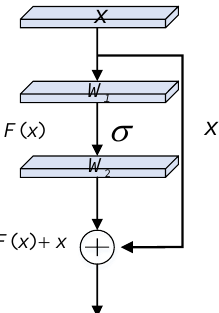
Figure 3. Residual connection.